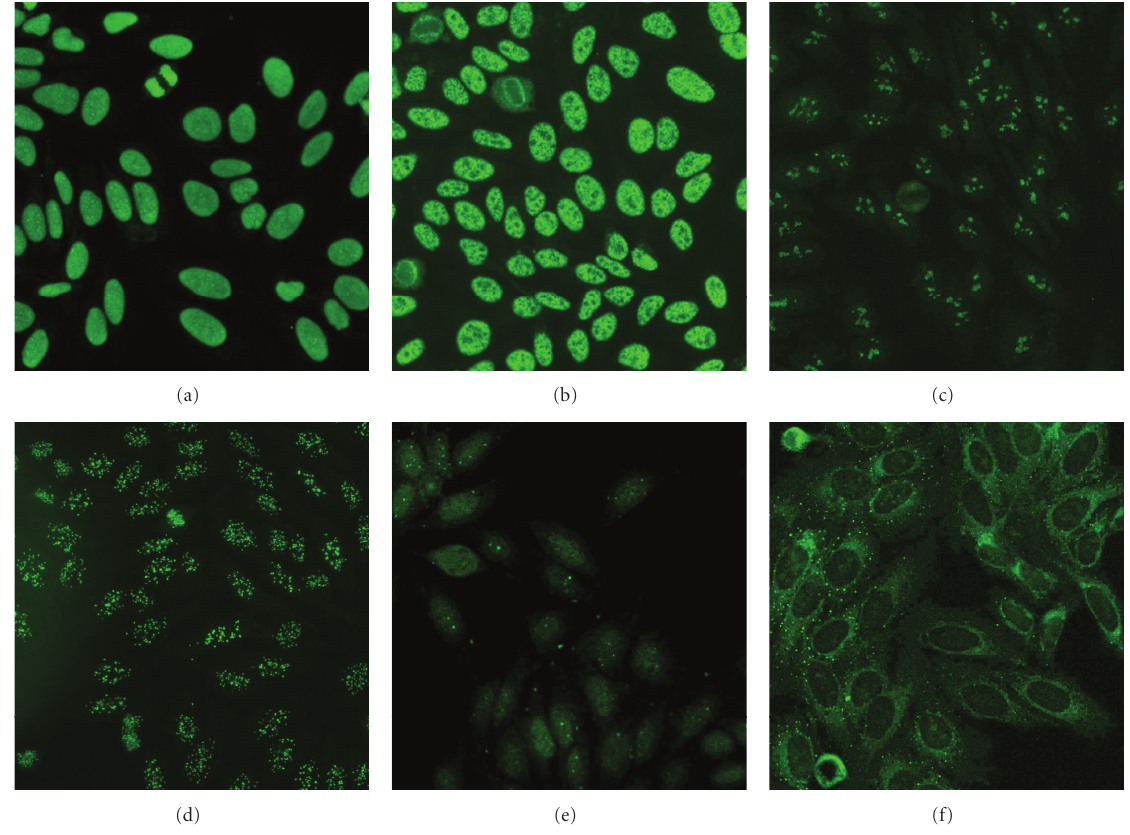
Figure 3: Representative indirect immunofluorescence patterns of antinuclear and anticytoplasmic autoantibodies on HEp-2 cells: (a) homogenous, (b) speckled, (c) nucleolar, (d) centromeres, (e) nuclear dots, and (f)